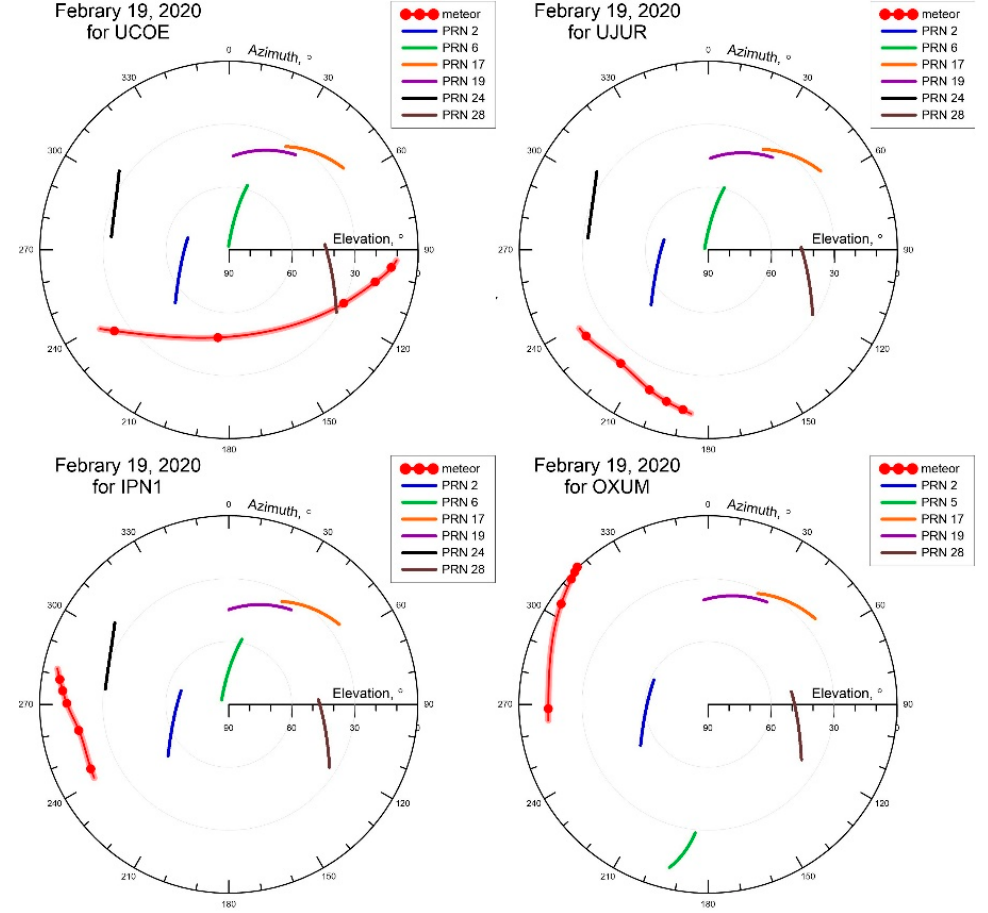
Figure 9. Sub-satellite and meteoroid trajectories with respect to UCOE, UJUR ( upper panels), IPN1 and OXUM locations ( lower panels).